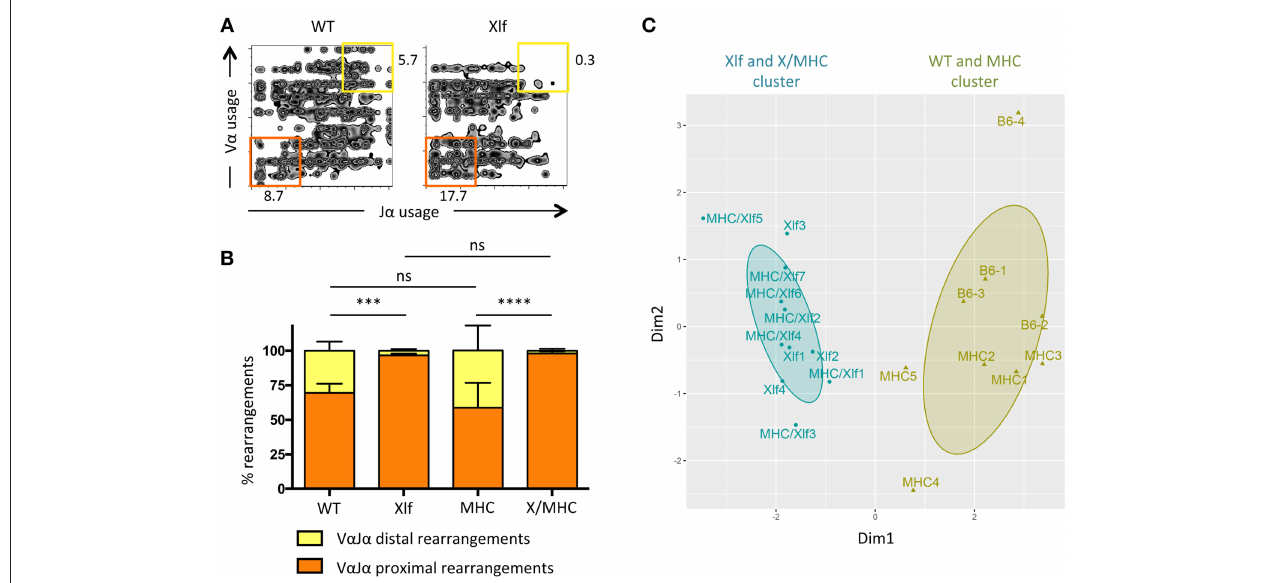
FIGURE 2 | Xlf − / − TCR α repertoire bias is independent of MHC driven antigen presentation during thymic development. (A) Illustrative 2-dimension plot representation of TCR α repertoire from whole thymus. Each node represents the association between one TRAV and one TRAJ segment as determined by TCR α transcript sequencing. (B) Relative usage of proximal and distal TRAV-TRAJ rearrangements. P -values were calculated using non-parametric Mann-Whitney tests. (C) Illustrative representation of Principal Component Analysis/unsupervised Hierarchical Clustering analysis (PCA/HC) analysis of TRAV and TRAJ usage in thymus according to PROMIDIS α